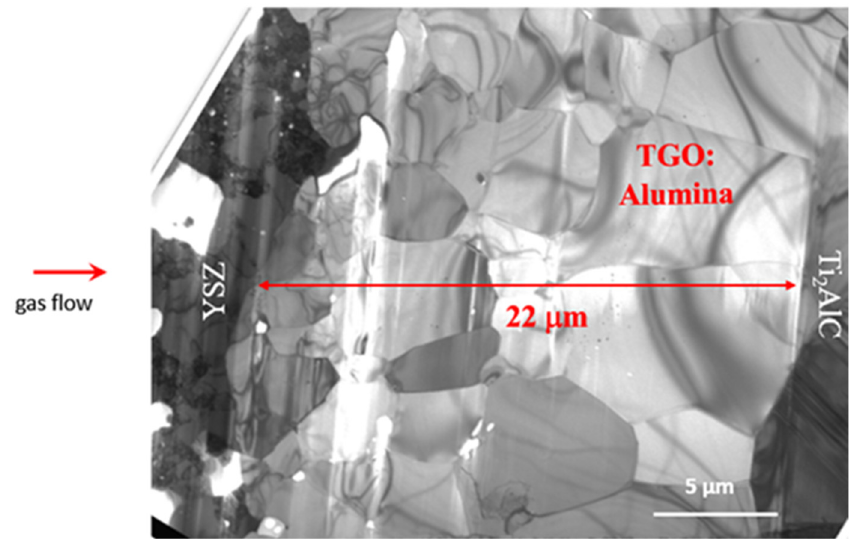
Figure 3. TEM Overview of the front side, FIB section I: TBC on the left, Ti2AlC MAX phase on the right. Avg. scale thickness from the prior SEM study was 22 μ m, as shown (500 h at 1300 °C).